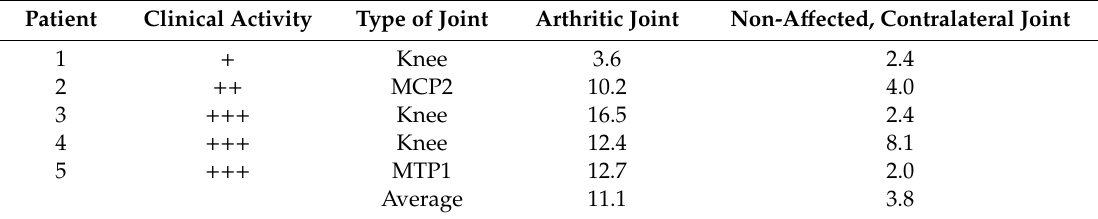
Table 4. Clinical activity with corresponding SUV peak for arthritic and non-affected, contralateral joints.